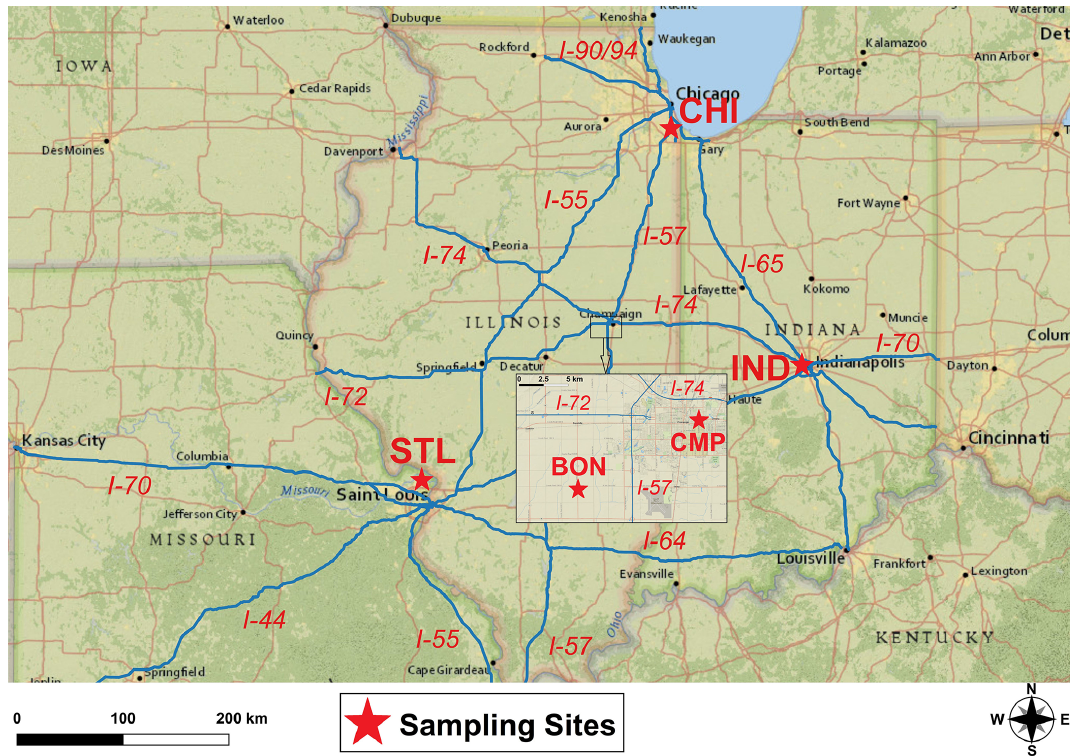
Figure 1. Map for our five sampling sites in the Midwestern